Question: What visual encoding does this figure use to show its data?
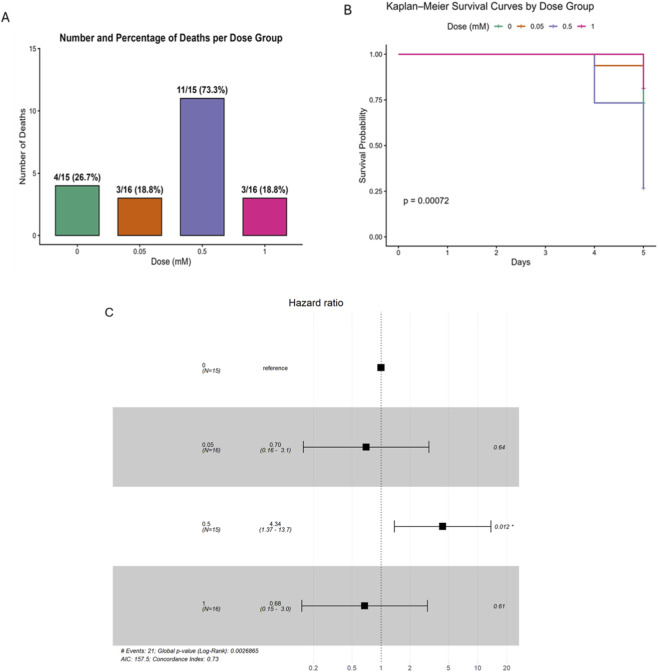
Answer: survival